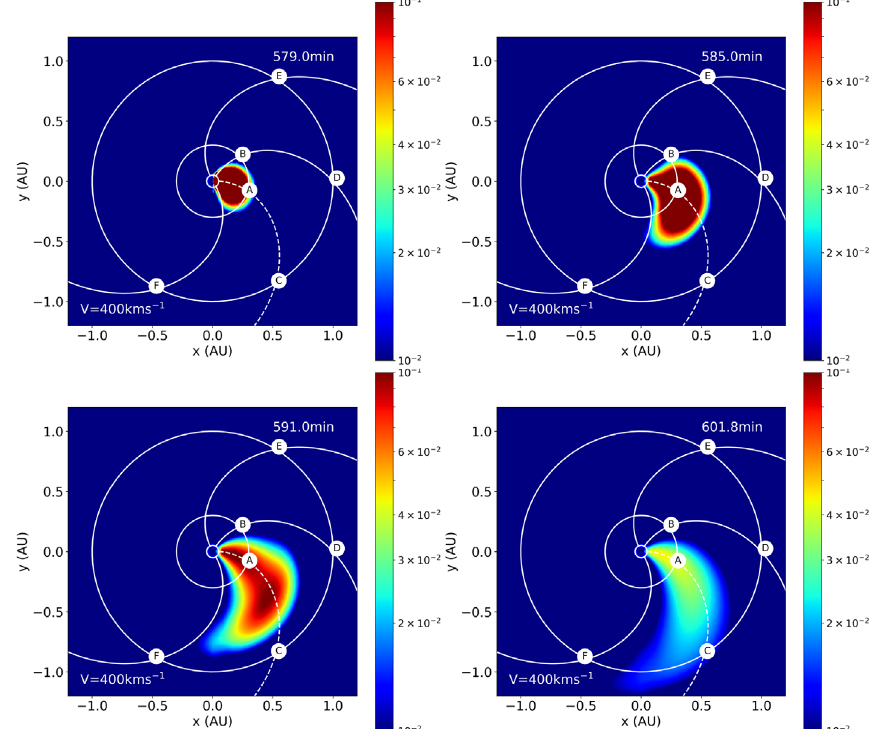
Fig. 4. Contour plots showing the temporal evolution of the omni-directional differential intensity, in the equatorial plane, for the third event of Figure 3. The labelled symbols indicate the position of the six virtual observers assumed in the model. The fi rst frame (579.0 min) shows the peak intensity reaching 0.3 AU while frames 2 and 3, both 6 min apart, show the effect of perpendicular diffusion. The last frame (~11 min later) shows the decay phase at 1